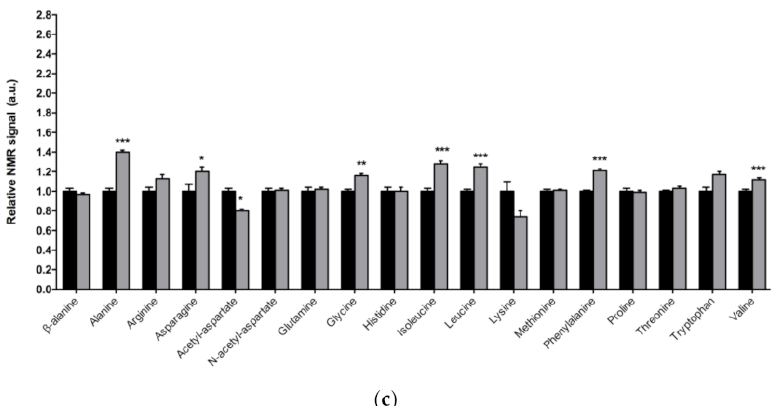
Figure 3. Alterations in amino acid content in PD model flies. Relative NMR signals of amino acids between ( a ) 1-day-old DJ-1 β mutant and control flies, ( b ) 15-day-old DJ-1 β mutant and control flies, and ( c ) 1-day-old and 15-day-old DJ-1 β mutant flies. In all cases, error bars show s.d. from twelve independent samples (*, p < 0.05; **, p < 0.01; ***, p <